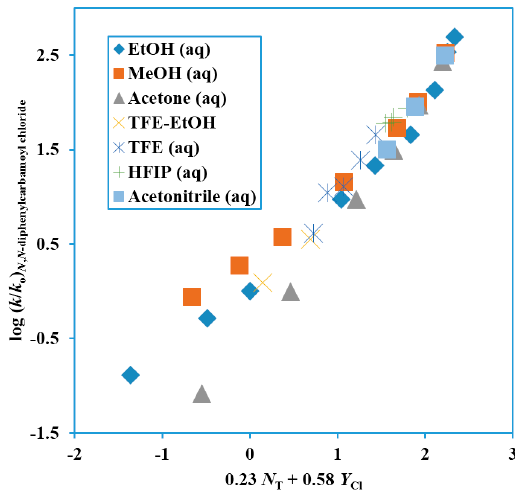
Figure 4. Plot of log ( k / k o ) for solvolyses of N , N -diphenylcarbamoyl chloride at 62.5 °C against 0.23 N T + 0.58 Y Cl .